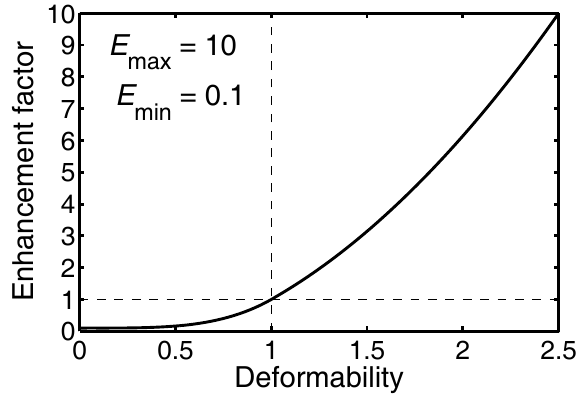
Fig. 4. Anisotropic enhancement factor ˆ E( A ) as a function of the polycrystal deformability A according to Eq. (19), for E max = 10 and E min = 0 .